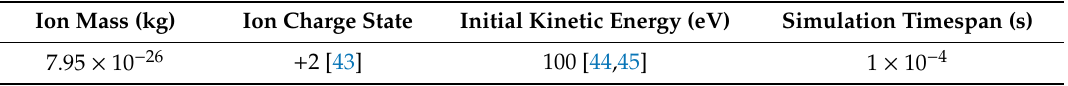
Table 2. Emission parameters of Ti ion.